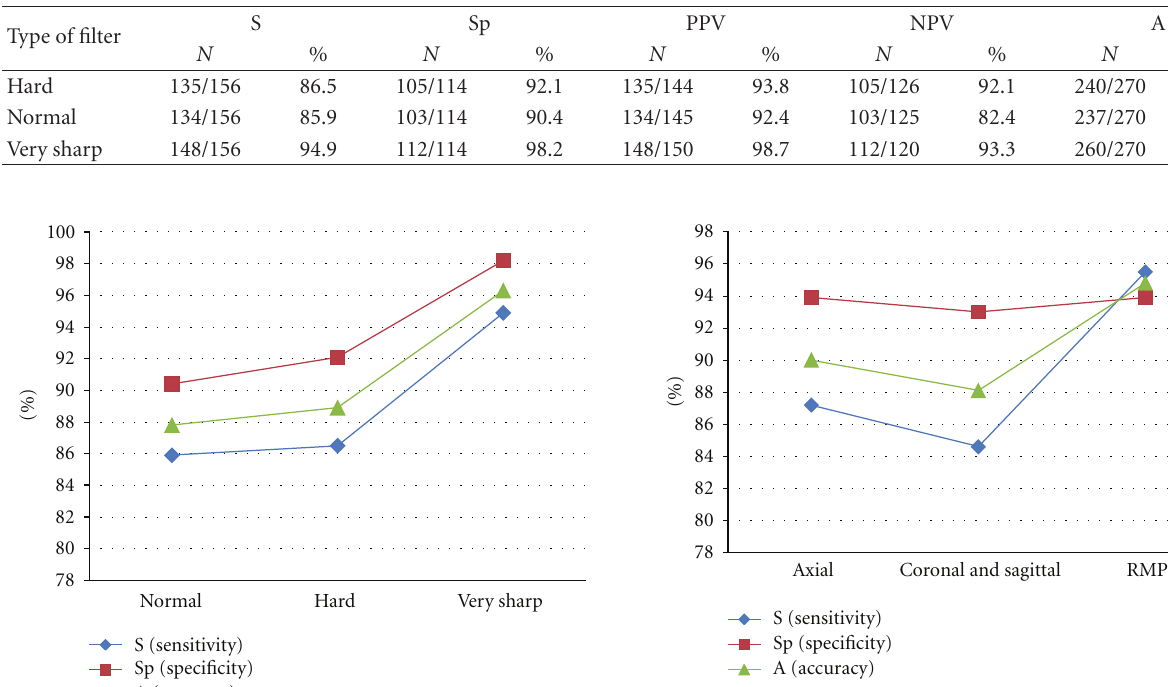
Table 2: Evaluation of the sensitivity (S), specificity (Sp), positive predictive value (PPV), negative predictive value (NPV), and accuracy (A), according to the type of filter, in the study of the presence or absence of simulated lesions.